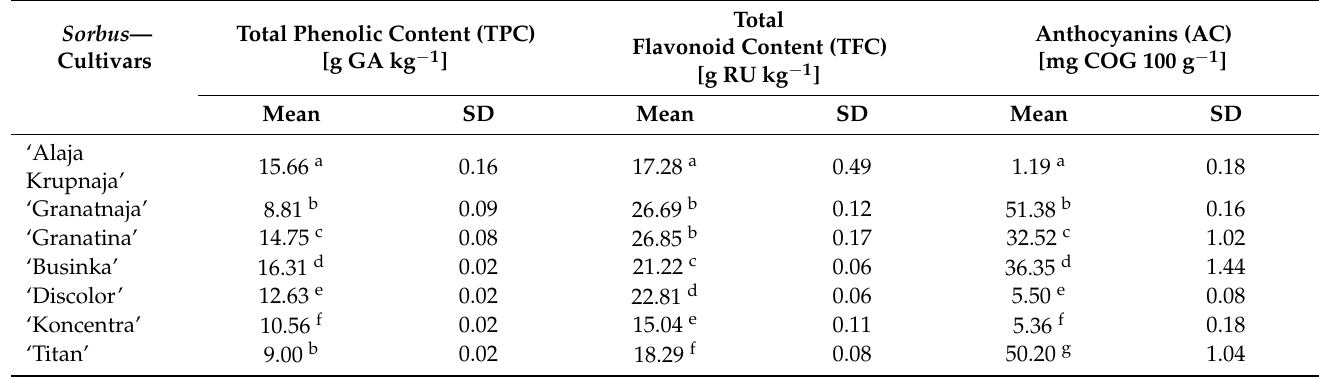
Table 3. Total phenolic content (TPC) [g GA kg − 1 ], total flavonoid content (TFC) [g Trolox kg − 1 ]